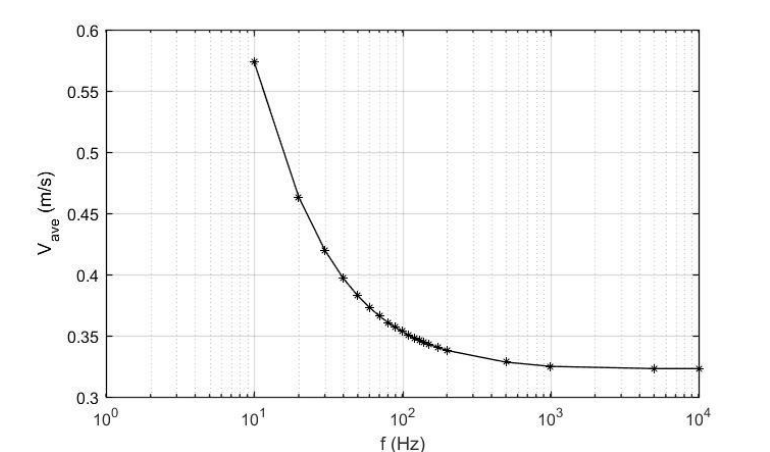
Figure 7 Effect of vibration frequency on average flushing speed.